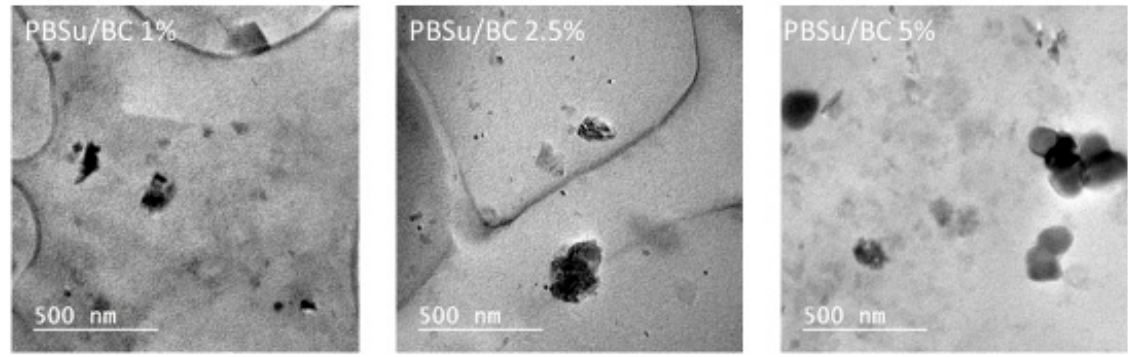
Figure 15. TEM micrographs of PBSu/BC composites with different BC content.